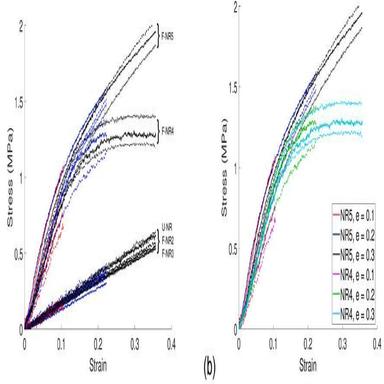
Results of varying strain quasi-static compression experiments at 10− 2 s − 1 and 25 ◦C for (a) all grades of rubber and (b) only 50% F-NRs to focus on strain activated damage.